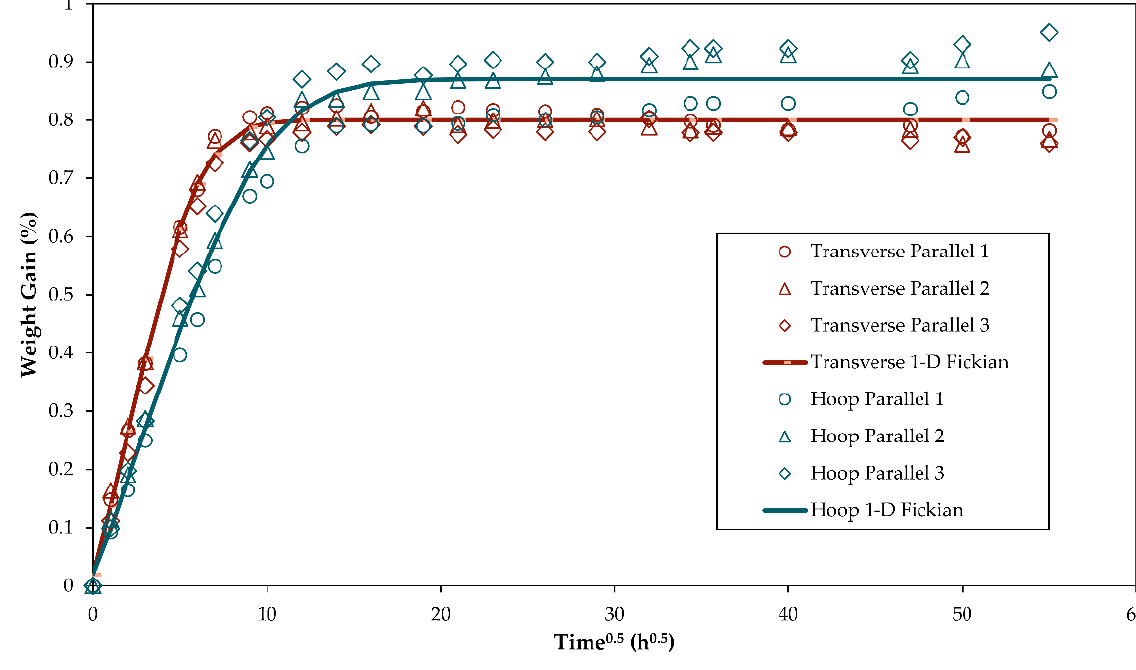
Figure 8. Water diffusion measurements.